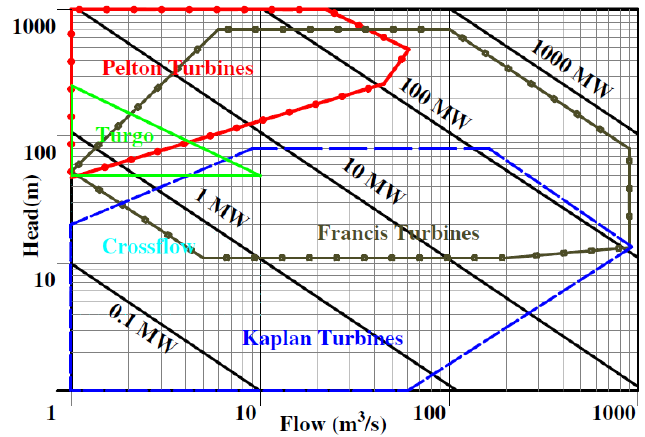
Figure 2. Turbine application chart [46].